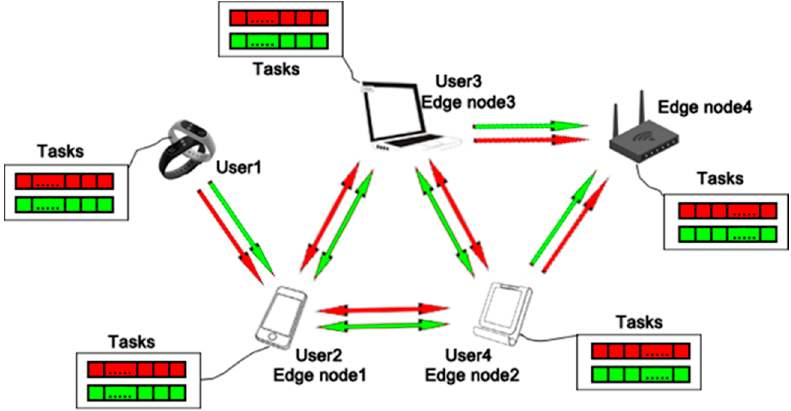
Figure 2. The structure of edge computing without using cloud center in smart home environment.